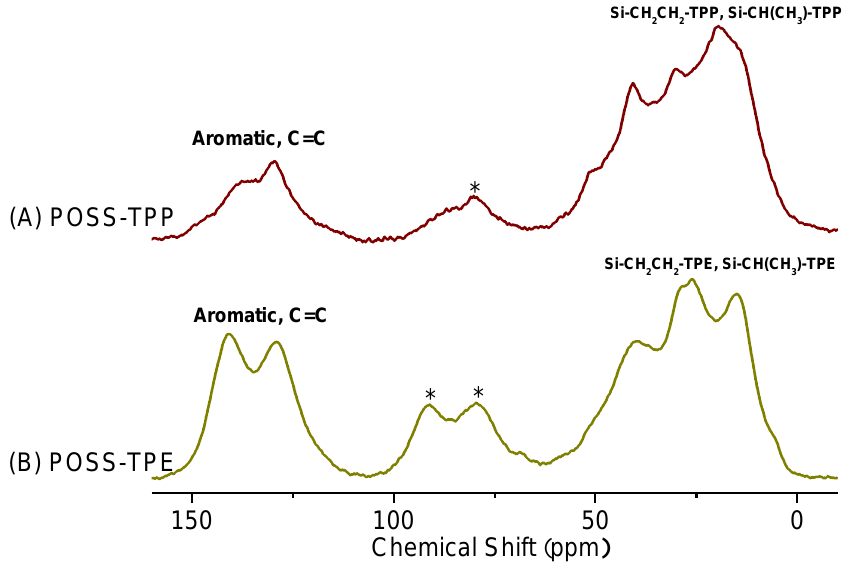
Figure 3. Solid-state 13 C CP/MAS NMR spectra of the states of ( A ) POSS-TPP and ( B ) POSS-TPE, where * is the side band of solid state nuclear magnetic resonance spectroscopy (NMR).